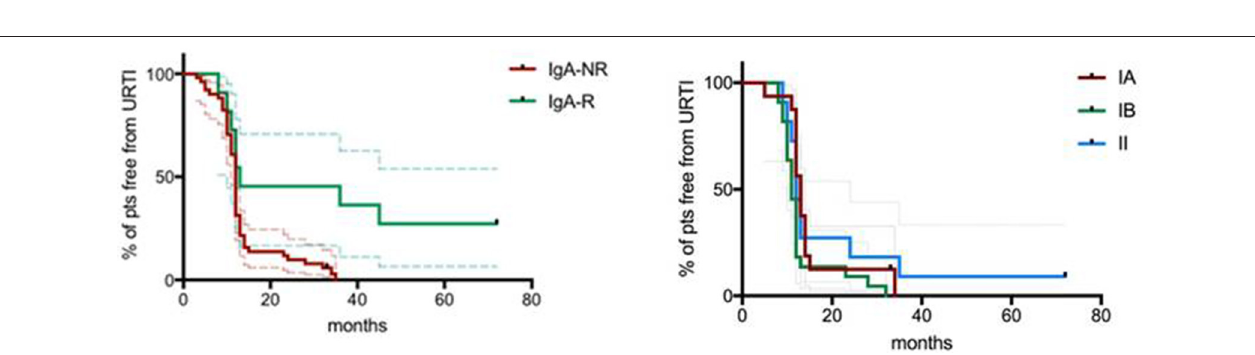
FIGURE 3 | Percentages of patients classified as IgA-NR and IgA-R belonging to group IA, IB and II by FREIBURG classification (A) and to group smB + , smB-, and B- by EUROCLASS classification (B) .